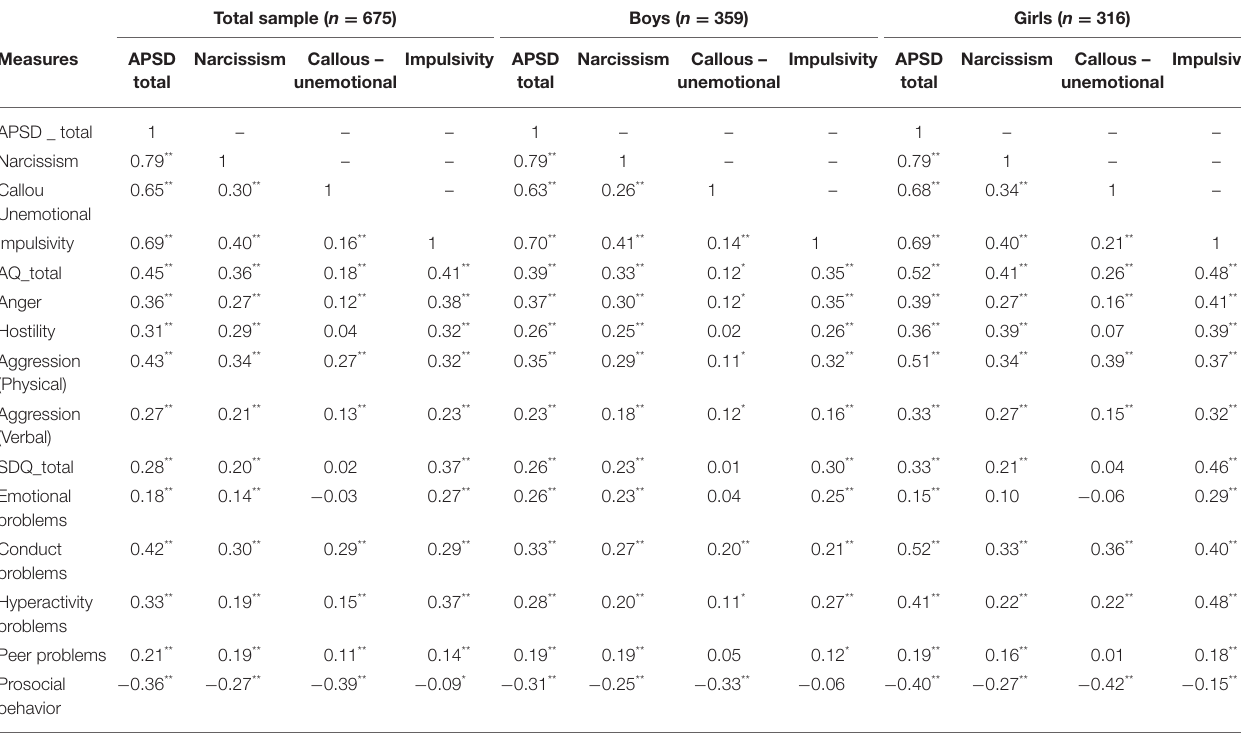
TABLE 4 | Correlations between APSD-SR scores and between APSD-SR scores and external correlates. Total sample ( n =